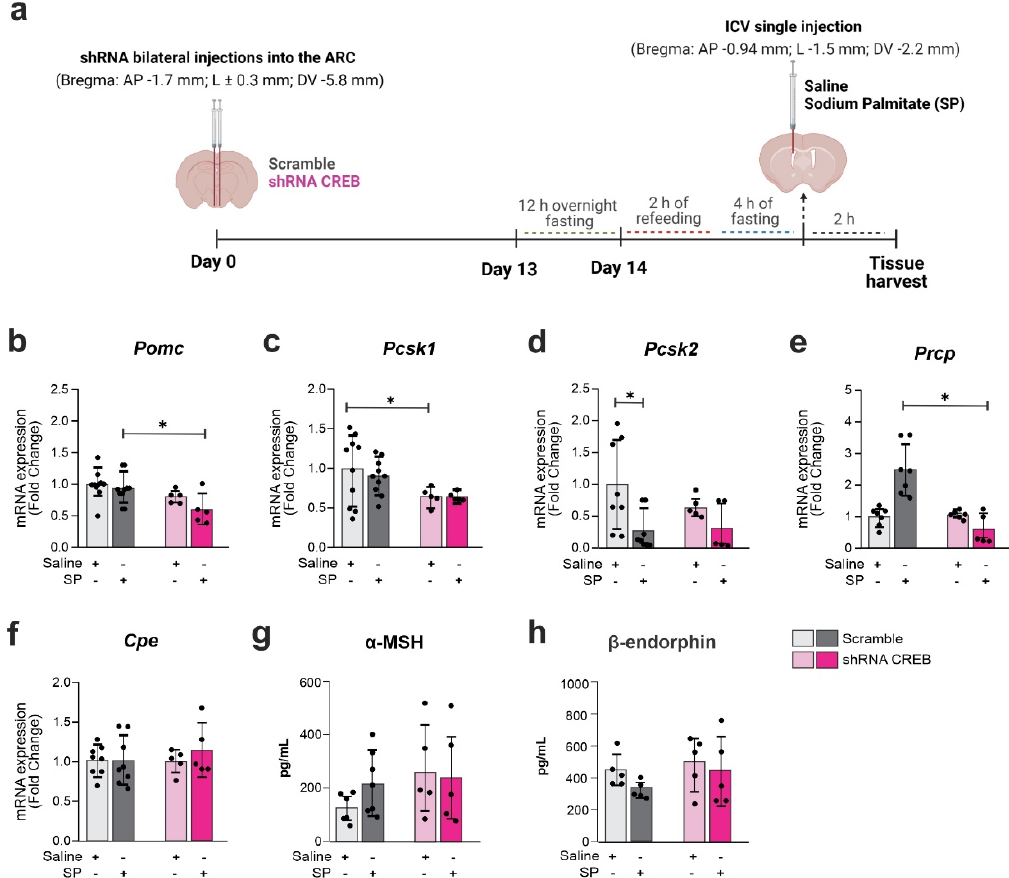
Figure 8. Reduced CREB expression changes Pomc cleavage enzymes expression upon palmitic acid stimulus. Adult male C57BL/6J mice were submitted to a bilateral injection of lentivirus particles (Scramble or shRNA CREB) into the arcuate nucleus (ARC) and, after 14 days, were ICV injected with saline or sodium palmitate (SP) 30 µM. ( a ) Schematic representation of experimental protocol; ( b – f ) Hypothalamic mRNA expression of Pomc and Pomc-related processing enzymes; ( g , h ) serum levels of Pomc peptide products. Data are presented as means ± SD. N = 5–8 mice. Two-way ANOVA followed by Sidak’s post hoc test was used for statistical analyses. * p ≤ 0,05 in comparison with groups indicated in the figure.